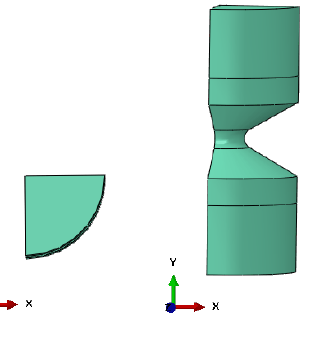
Figure 1. The geometry of a diabolo-shaped specimen.